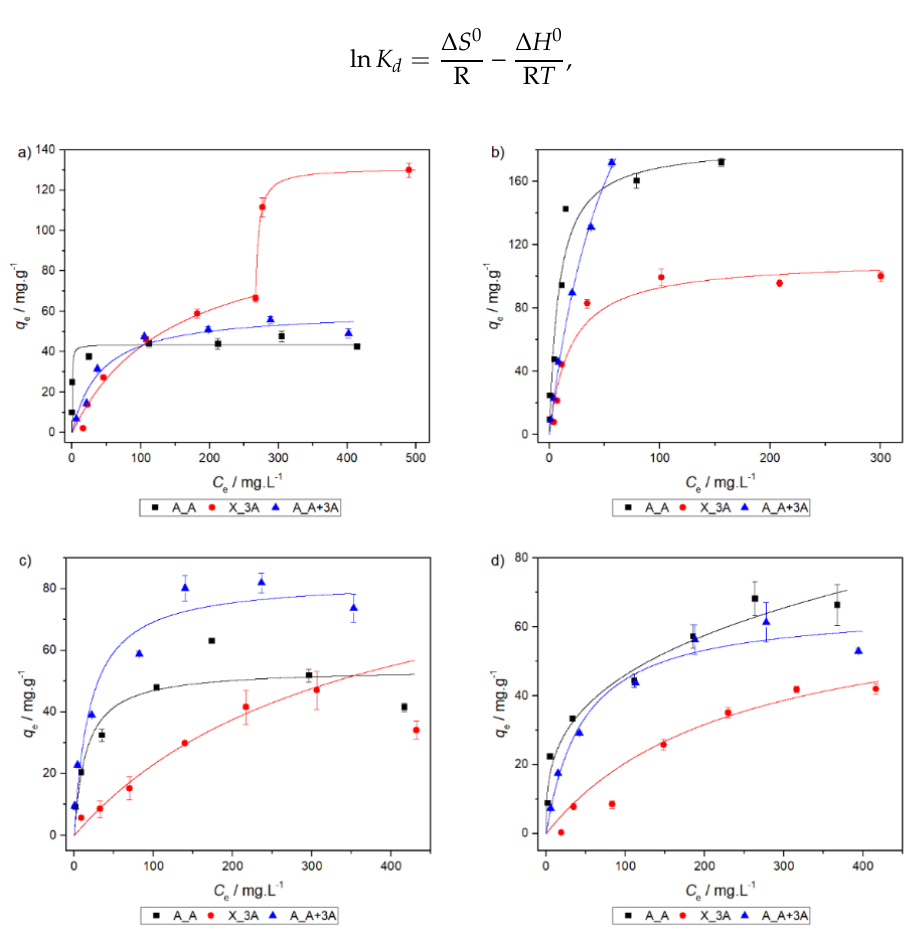
Figure 6. Sorption isotherms for ( a ) copper, ( b ) lead, ( c ) cadmium and ( d ) nickel. Table 6. Adsorption models and fitting parameters for sorption